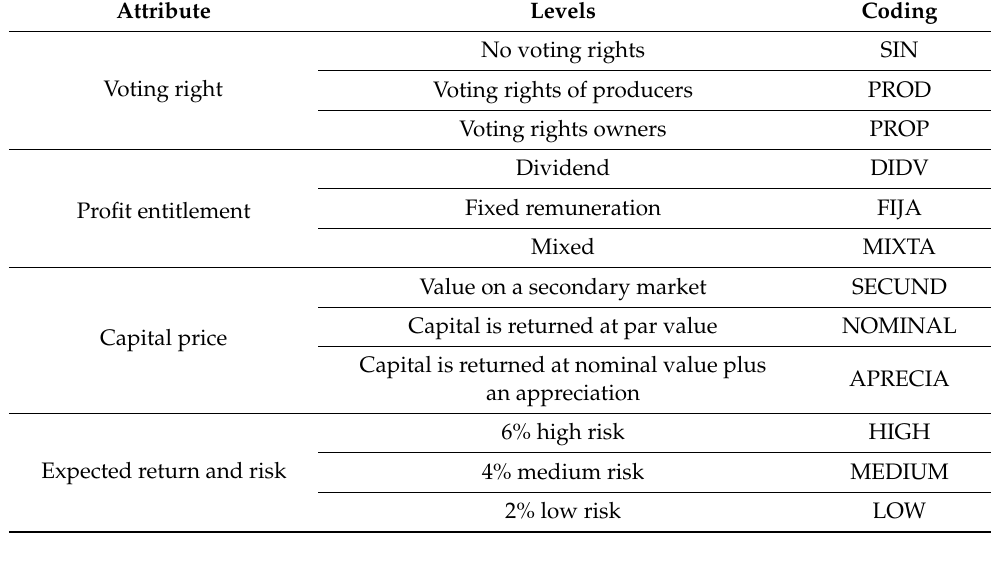
Table 2. Attributes and levels of the Choice Set.